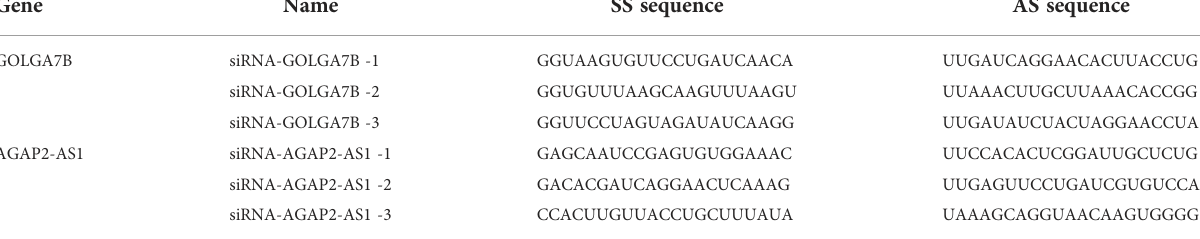
TABLE 1 The siRNA for target